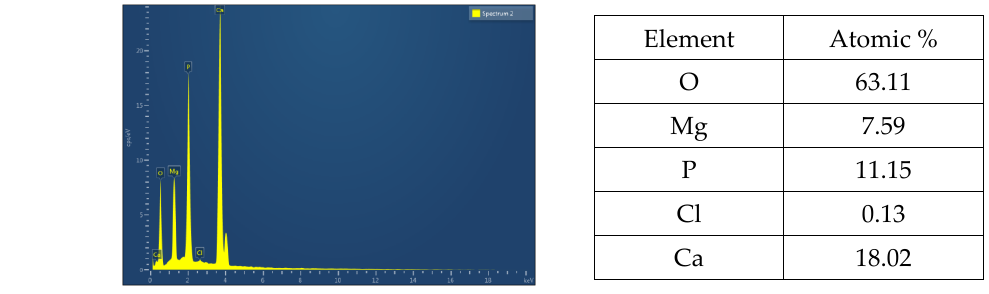
Figure 4. EDS spectra of as-prepared Mg-HA.